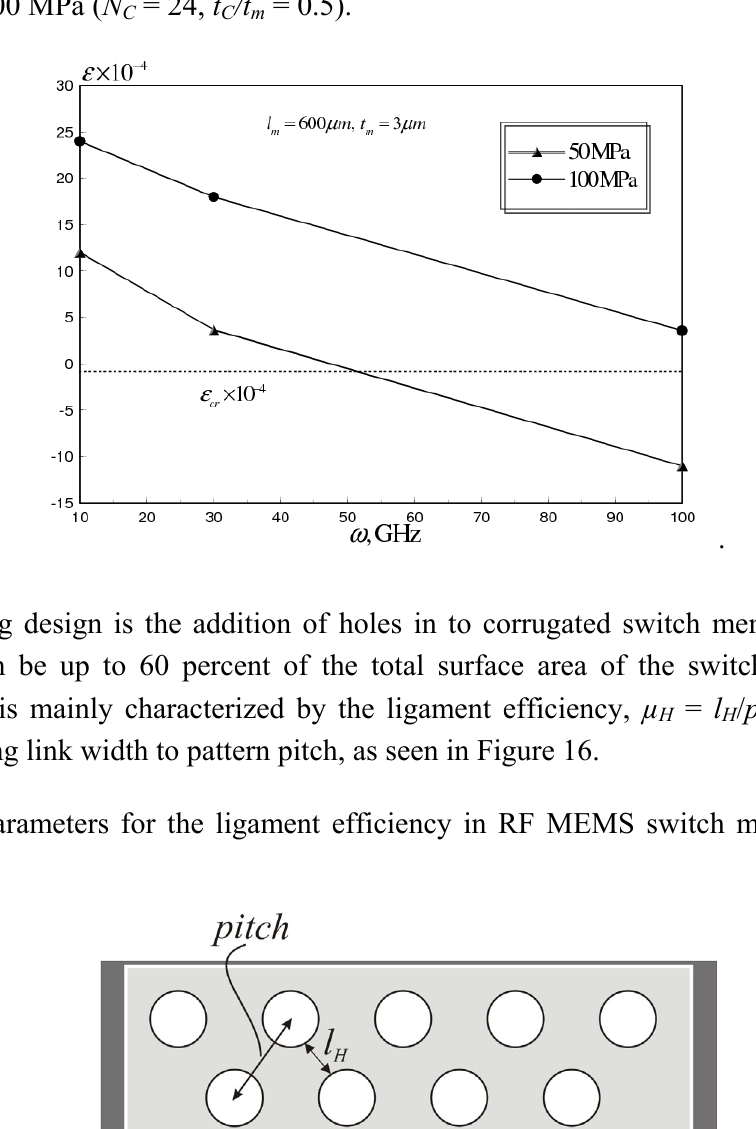
Figure 15. Average axial strain versus ω of corrugated aluminum RF MEMS switch at σ